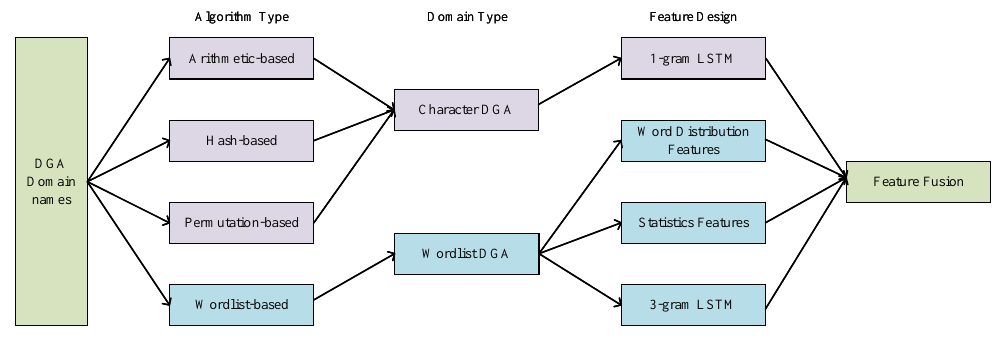
Figure 1. Overall concept of the detection